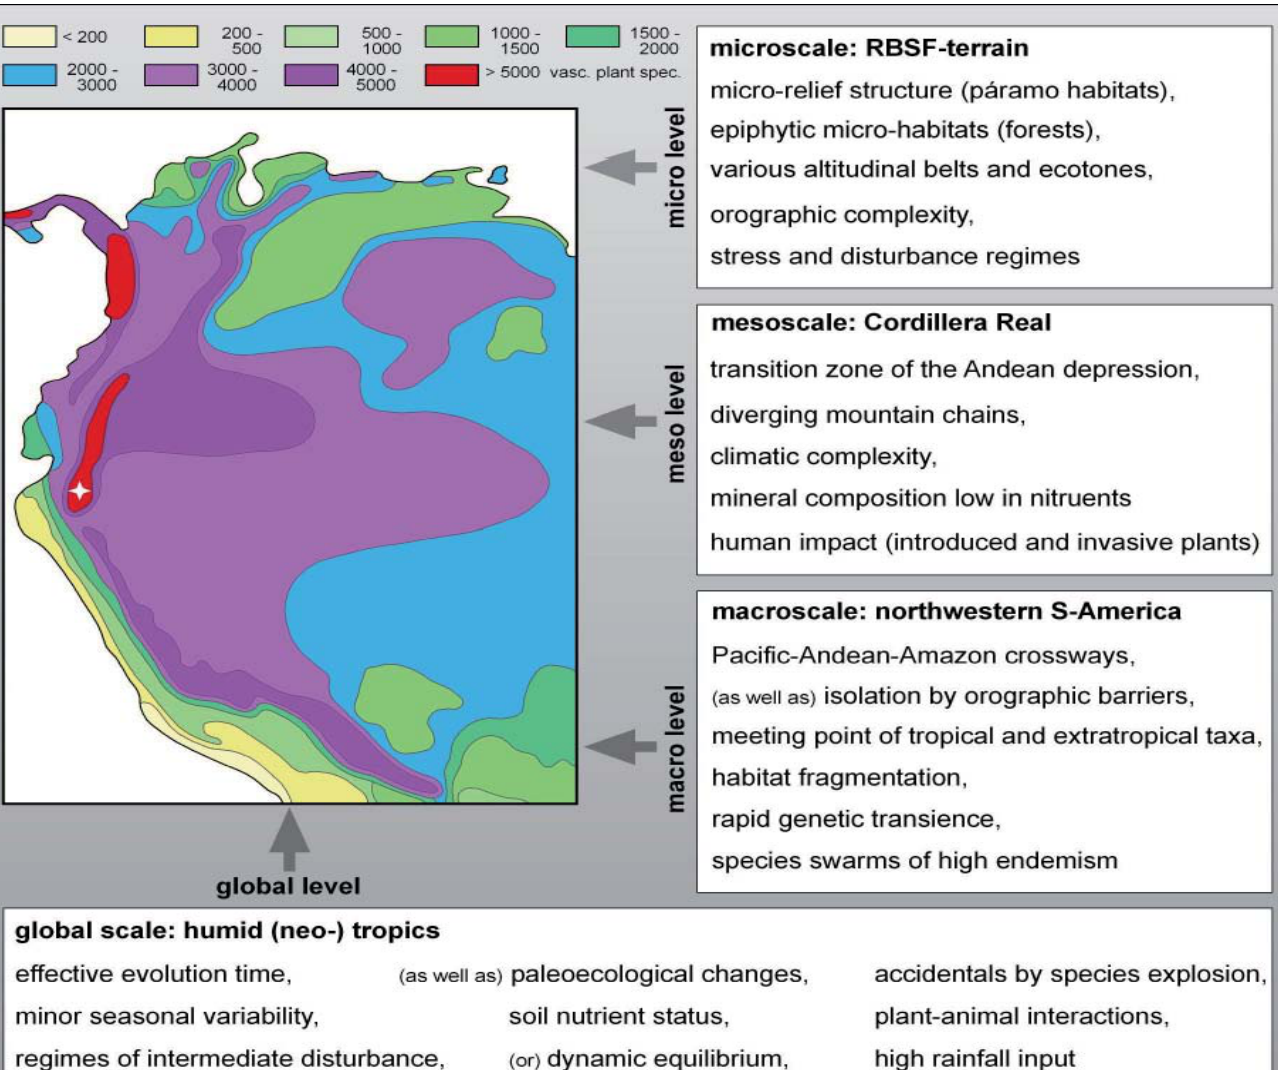
Figure 20: Scale dependent factors contributing to plant diversity in the study area in southern Ecuador. The four levels from global to microscale are expressed by boxes. The plant diversity map on the upper left is based on a section of a recent world map by Barthlott et al.